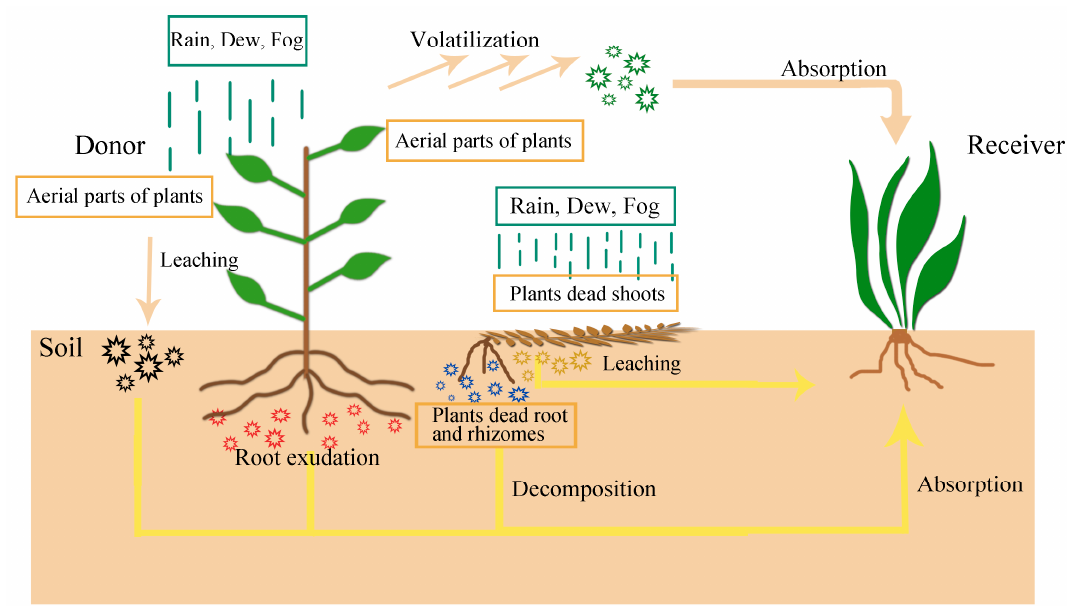
Figure 1. The allelopathy pathways of plants.